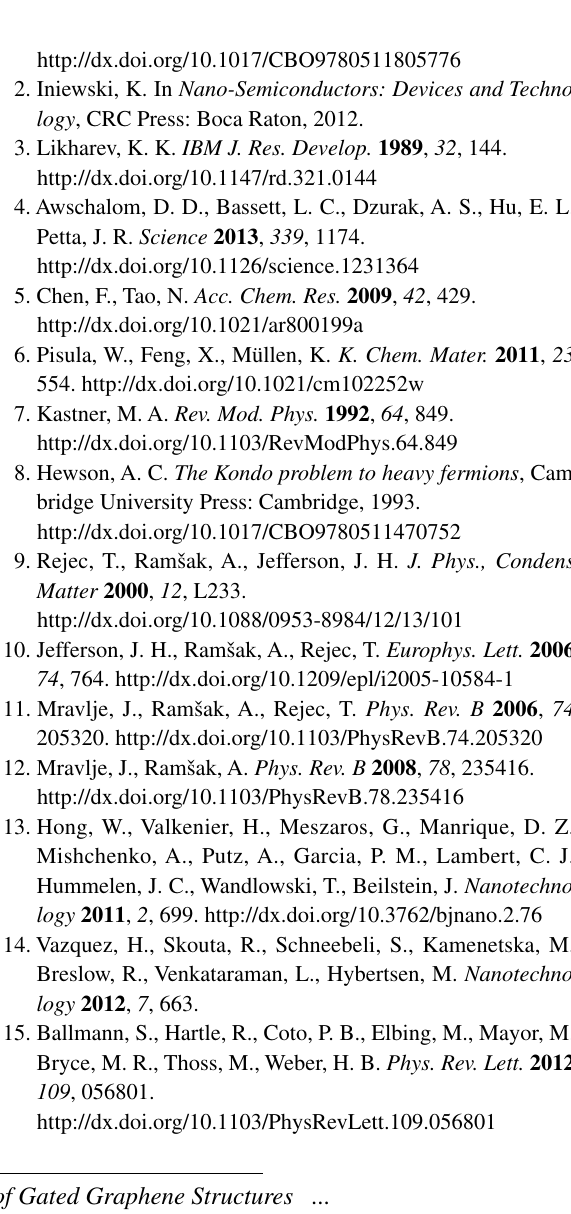
= 0 (dashed lines). Full lines show magic ratios for ε 0